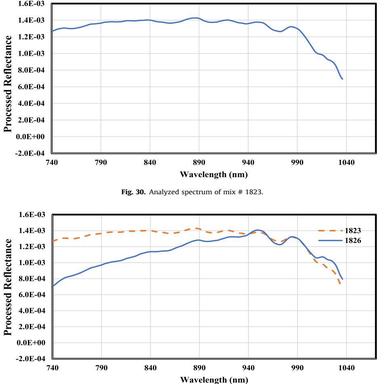
Comparing two dense graded mixtures (mixes # 1823 and 1826).